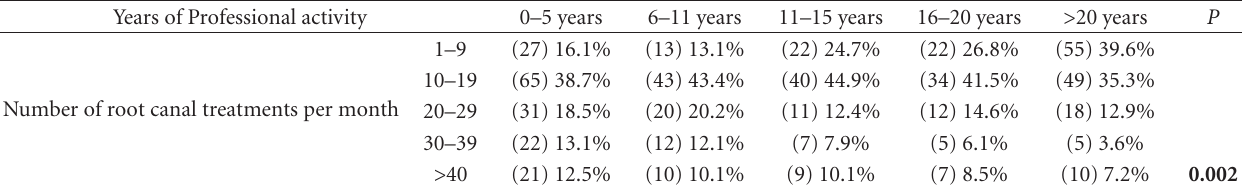
Table 2: Frequency and number of endodontic treatments according to years of professional